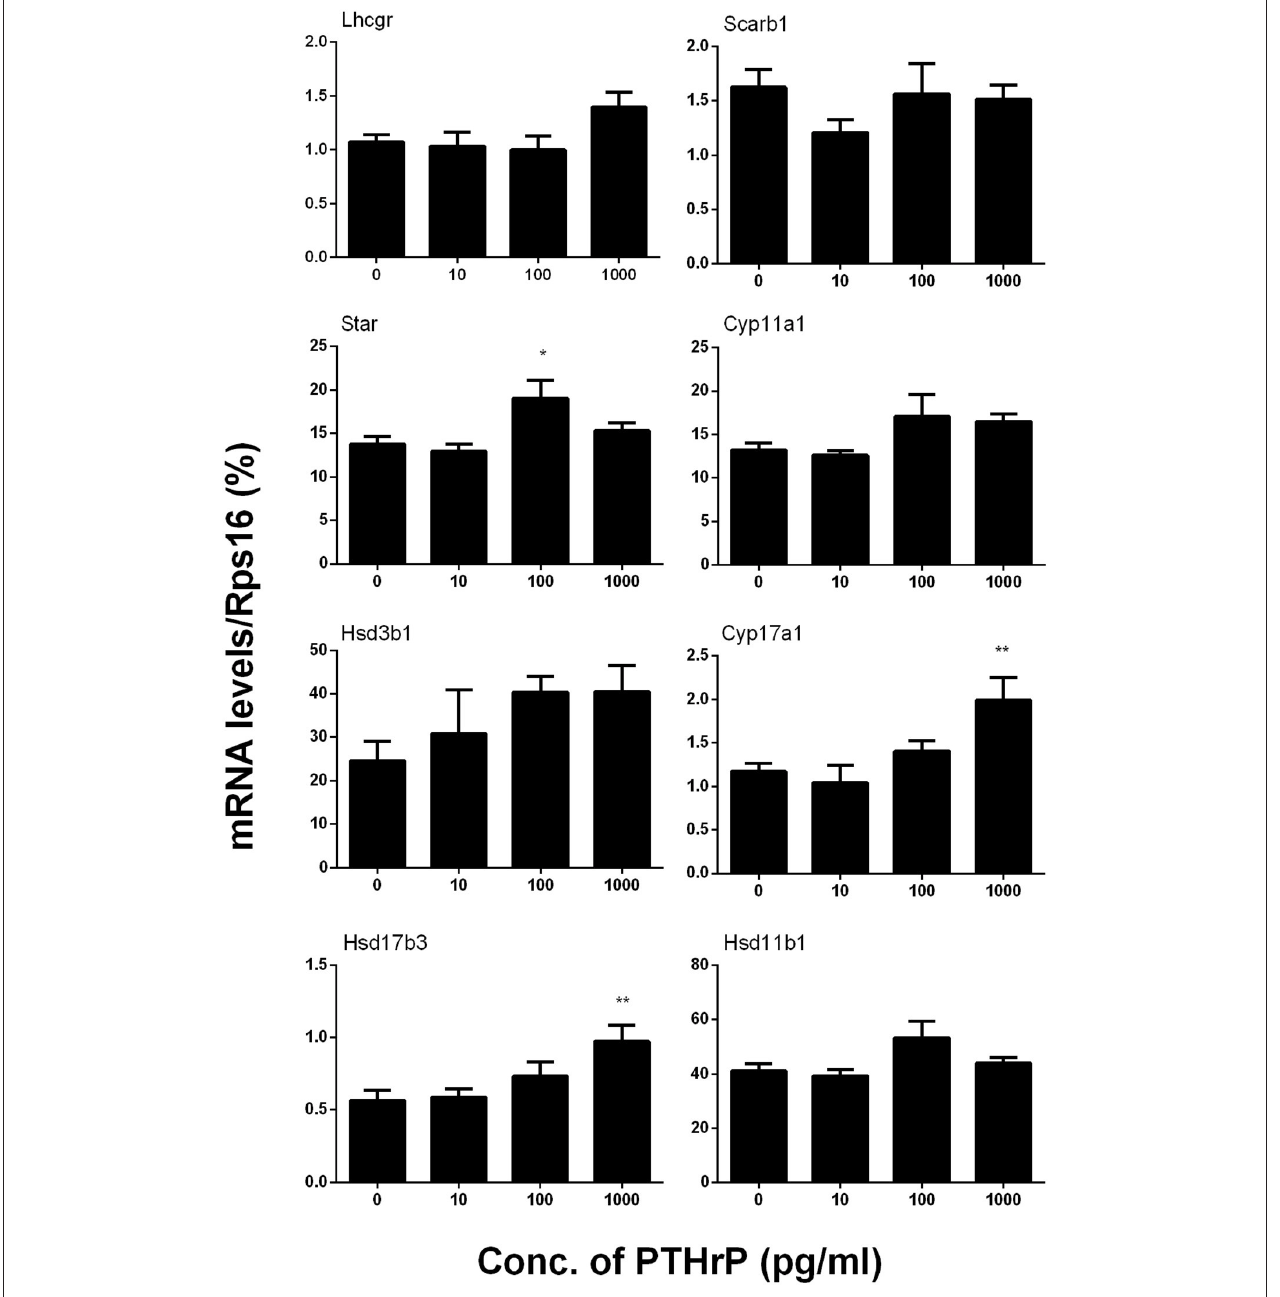
FIGURE 2 | PTHrP up-regulates the expression levels of some Leydig cell-specific genes in vitro . The mRNA levels of Lhcgr , Scarb1 , Star , Cyp11a1 , Hsd3b1 , Cyp17a1 , Hsd17b3 , and Hsd11b1 were analyzed by qPCR in the seminiferous tubules treated with 0, 10, 100, and 1,000 pg/ml PTHrP for 14 days. Mean ± SEM, n = 6, * P < 0.05, ** P < 0.01 when compared to the control.